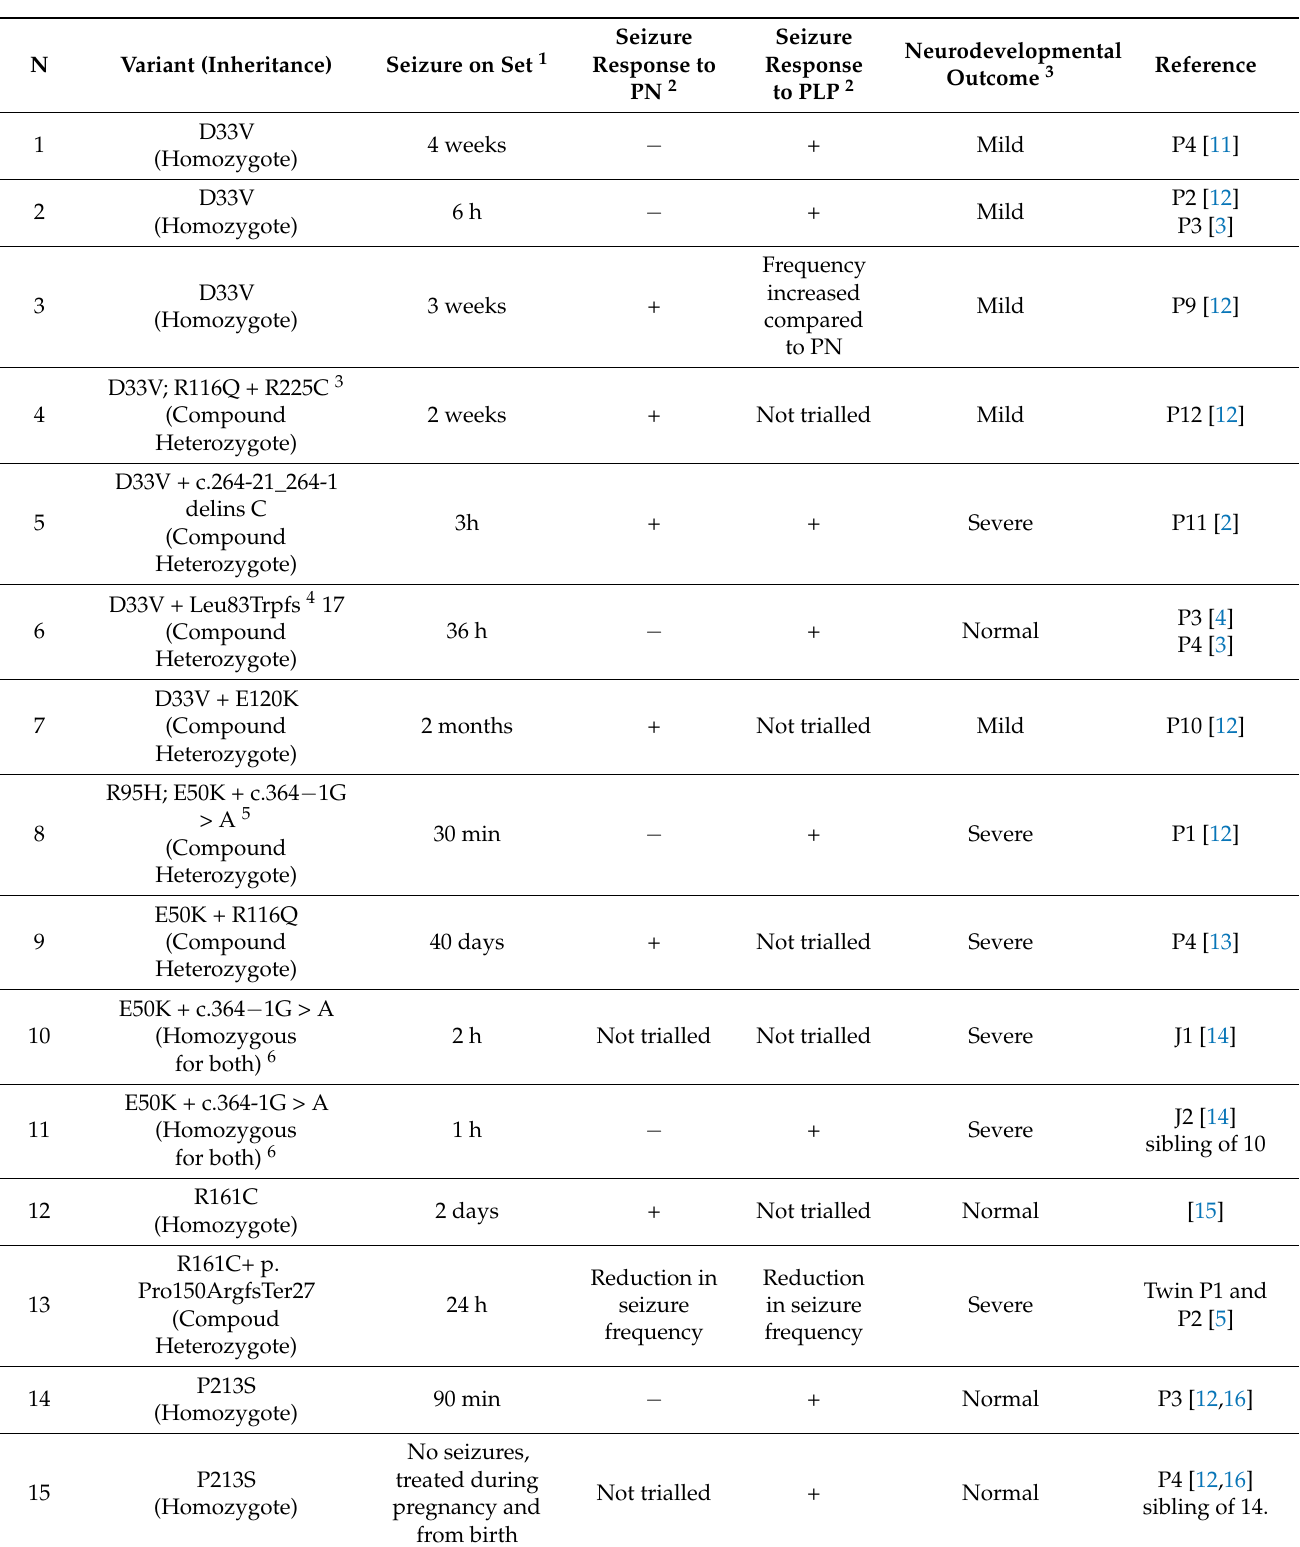
Table 2. Summary of medical observations of patients with the variants characterized in this